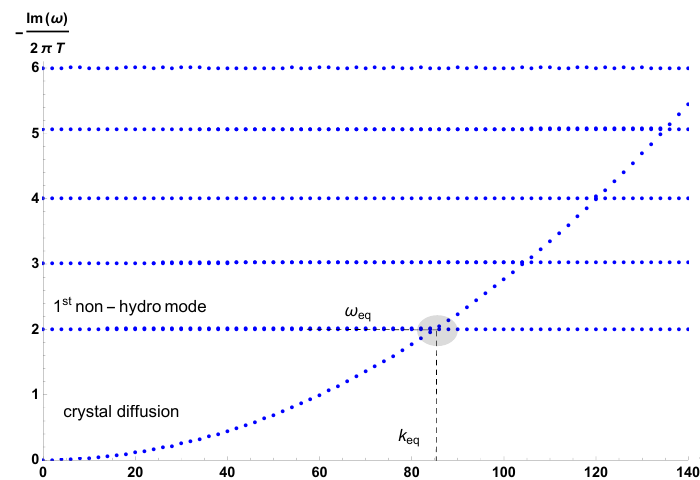
Figure 2 . The longitudinal spectrum of quasinormal modes for N = 3 and m/T = 500 . For simplicity, the attenuation constant of the longitudinal sound modes has been manually removed. The gray region emphasizes the location of the collision between the crystal diffusion mode and the first non-hydrodynamic AdS mode, from which the parameters ω are extracted as shown 2 eq , k eq by the dashed lines. The tower of non-hydrodynamic modes follow the expected trend ω = n 2 πT ( n + ∆) , where in this case ∆ = 2 . Similar pictures can be obtained for different values N and of m/T